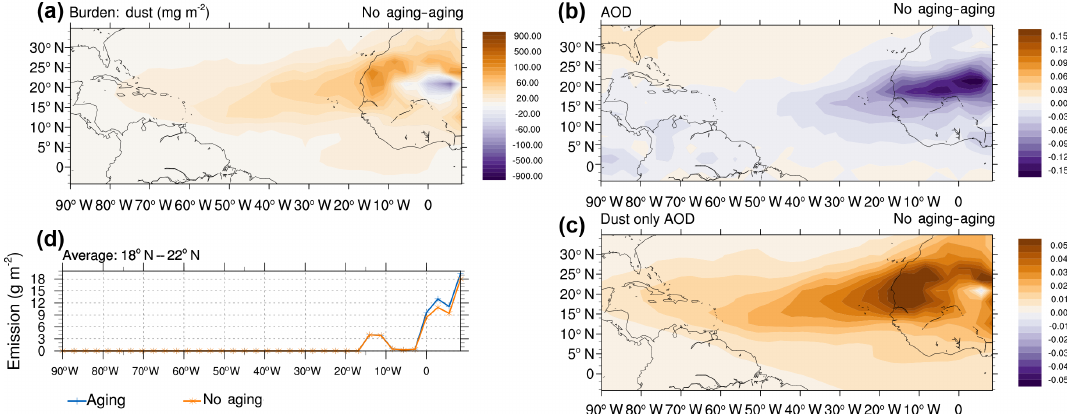
Figure 13. EMAC results (July 2009 monthly mean) for two simulations that include and exclude chemical aging (labeled “aging” and “no aging”, respectively). The (a) difference in dust burden, (b) difference in AOD and (c) the dust emission averaged for the region from 18 to 22 ◦ N for both simulations. The (d) difference in “dust only AOD”. “Aging” is the reference case. The difference shows the results of the “no aging” minus the “aging”